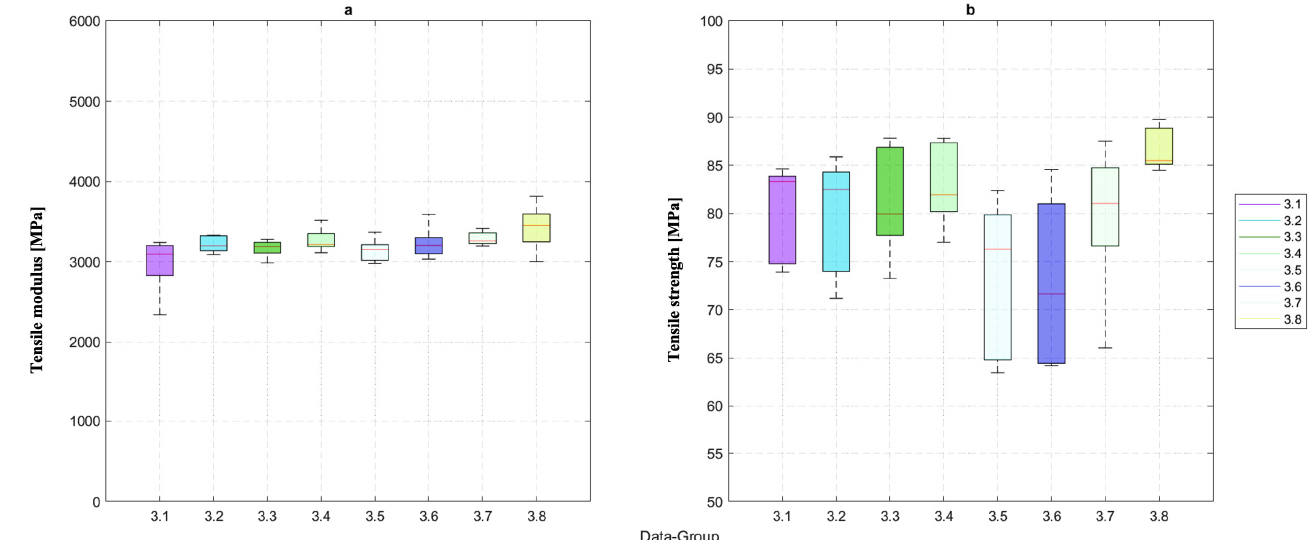
Figure 5. The ( a ) tensile modulus and ( b ) tensile strength of PEEK printed samples of all subgroups of group 3.